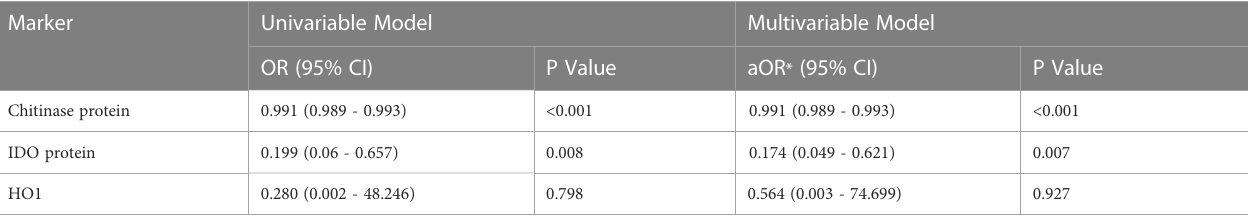
TABLE 2 Association of the respective biomarkers with favorable treatment outcomes.